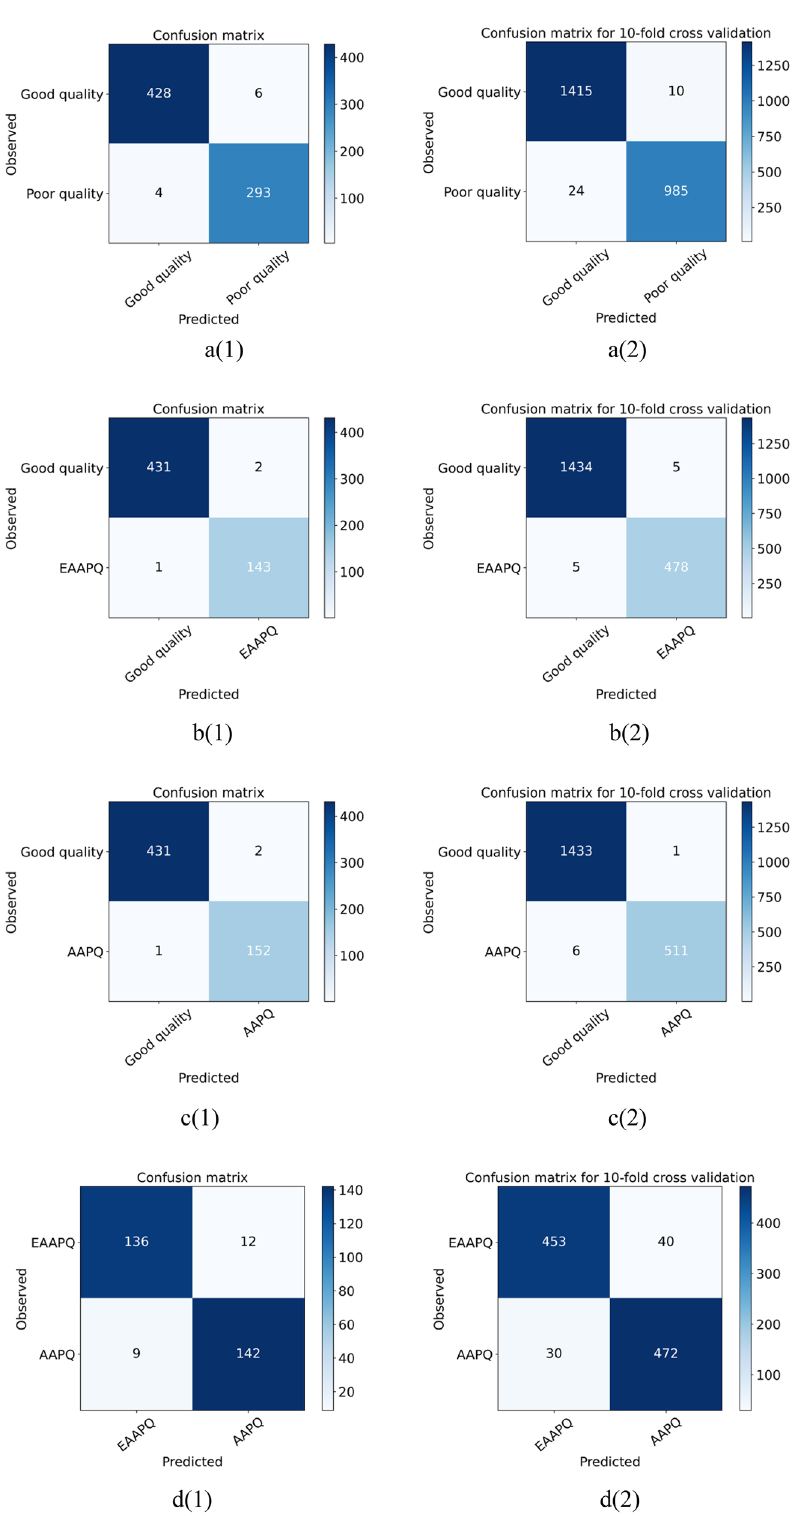
Figure 3. Confusion matrix of testing (1) and 10-fold cross validation (2). ( a(1) , a(2) ) Good quality VS Poor quality; ( b(1) , b(2) ) Good quality VS Eye-abnormality-associated-poor-quality; ( c(1) , c(2) ) Good quality VS Artefact-associated-poor-quality; ( d(1) , d(2) ) Eye-abnormality-associated-poor-quality VS Artefact-associated-